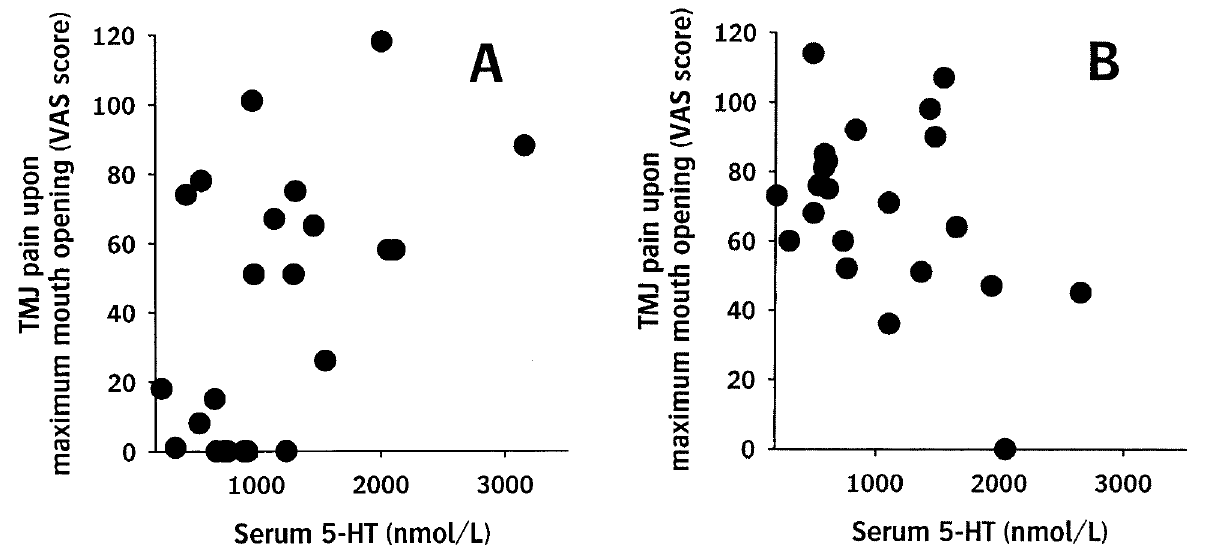
FIG. 2. Scatter plot showing the relation between the serum level of 5-HT and TMJ pain intensity, as assessed with a VAS (0–100mm), experienced on maximum mouth opening in patients with (A) seropositive RA ( r s = 0.41, n = 24, p = 0.047) and (B) seronegative RA ( r s = –0.27, n = 23, p = 0.214)